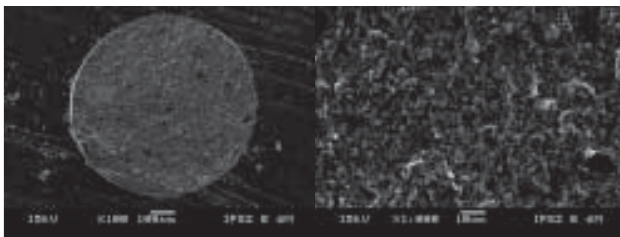
Fig 2. SEM of IPS Empress 2: Cohesive fracture pattern (arrow) (A- Original magnification X 100; B- Original magnification X 1000).